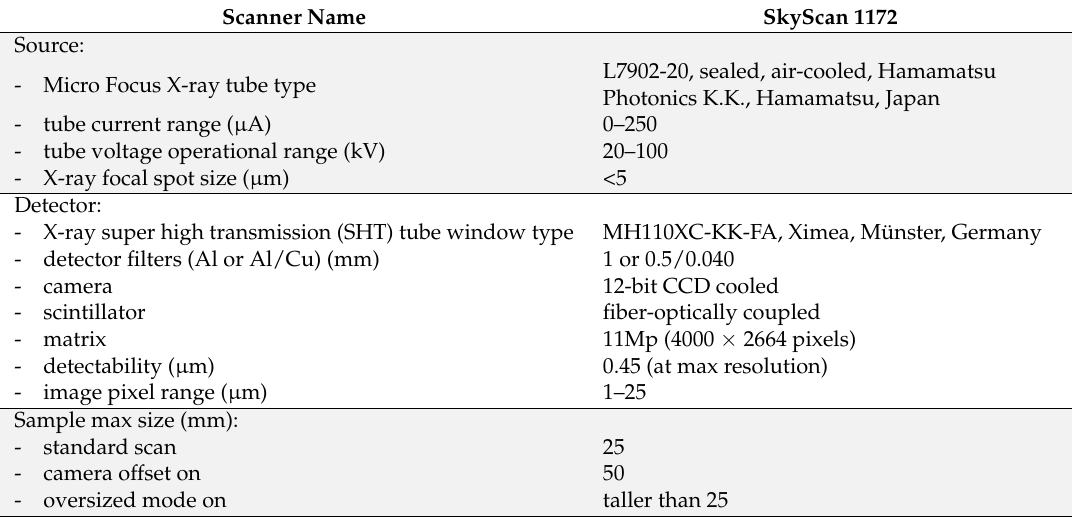
Table 4. Technical specifications of the